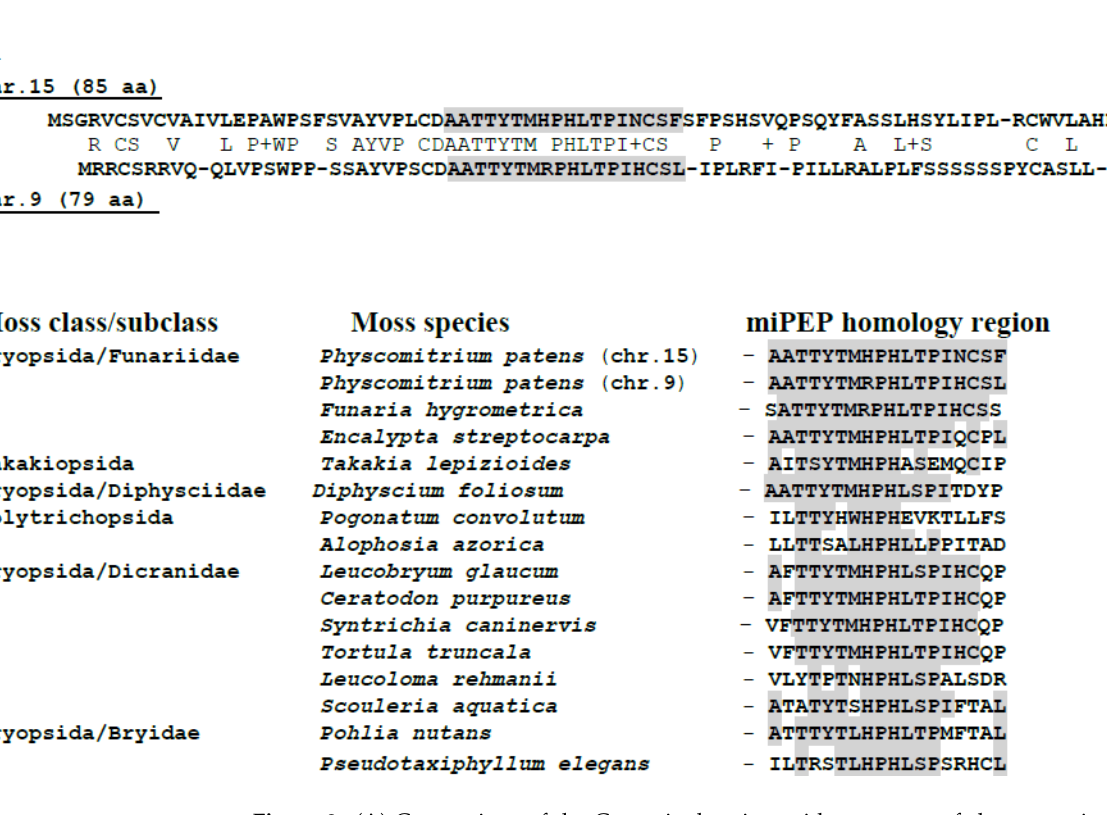
Figure 2. ( A ) Comparison of the C-terminal amino acid sequences of short proteins encoded by pri-miR160a genes from chromosomes 9 and 15 of P. patens . The sizes of proteins are indicated in parentheses. Peptide sequences of both miPEPs encoded by chromosomes 9 and 15 of P. patens and preserved in other mosses are marked by shading. ( B ) Comparison of amino acid sequences of highly conserved peptide blocks in three classes of mosses. Residues identical to those identified in the sequences of short Ppt -miPEP160a proteins are marked by